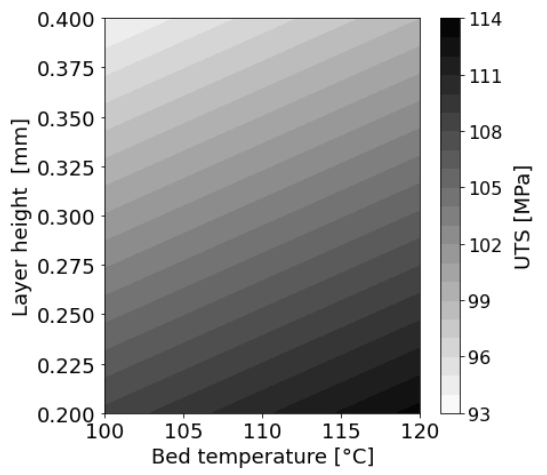
Figure A4. Contour plot for T bed and v based on DoE prediction model.